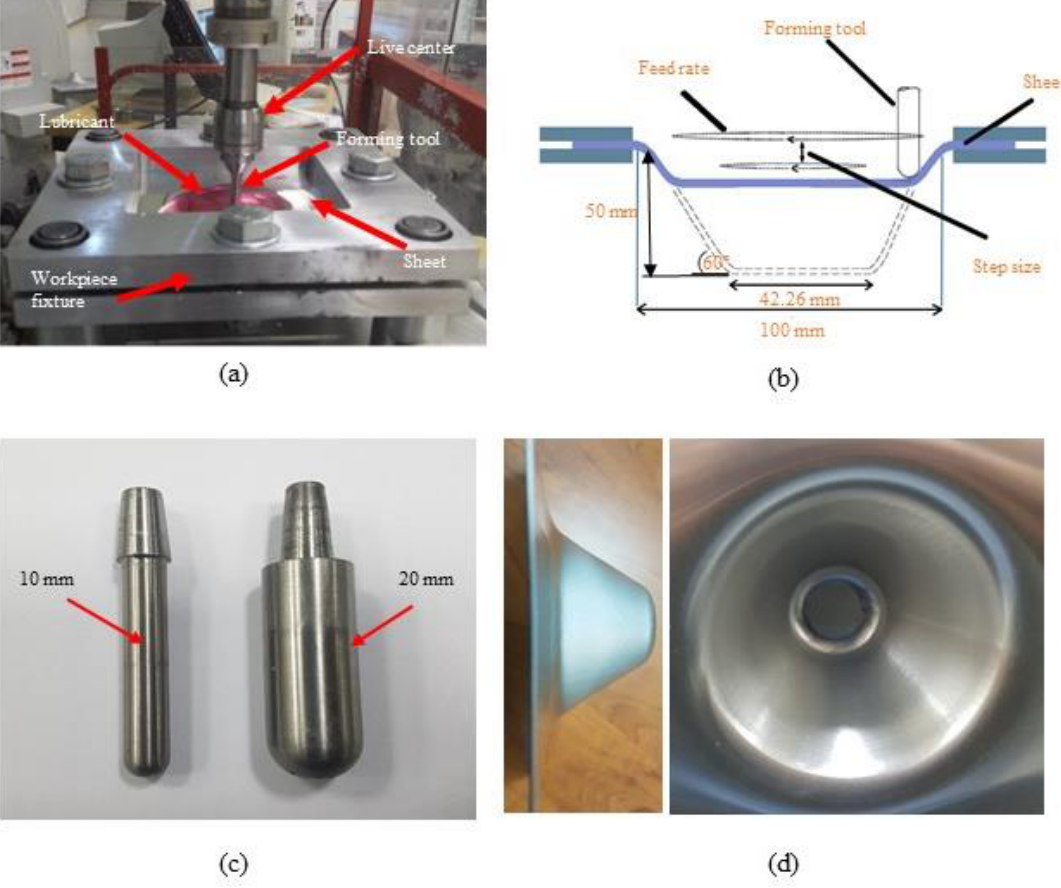
Figure 1. ( a ) Fixture and machine setup, ( b ) part dimensions and the investigated process parameters, ( c ) forming tools, and ( d ) final part.